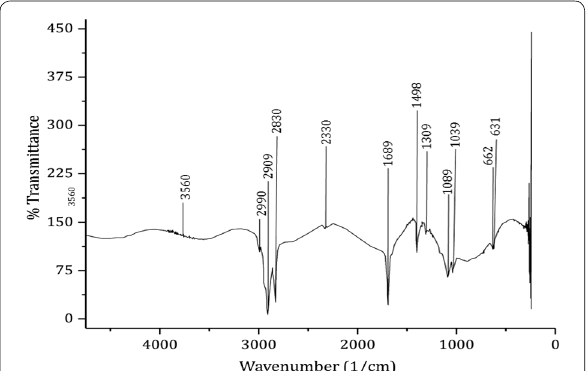
Fig. 2 Fourier Transform Infrared Radiation (FTIR) spectrum of WO‑RP